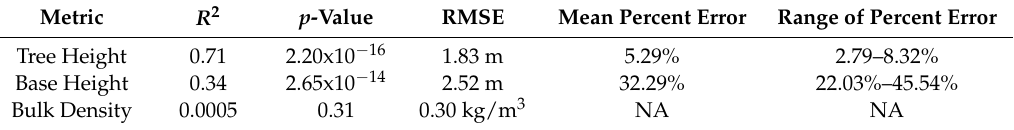
Table 4. Results comparing UAV-derived and field-derived individual tree metrics. R 2 , p-value, and RMSE were calculated by linear regression. The mean percent error and range of percent error were calculated using a bootstrap resampling analysis with the percent error between UAV-derived and field-derived estimates.